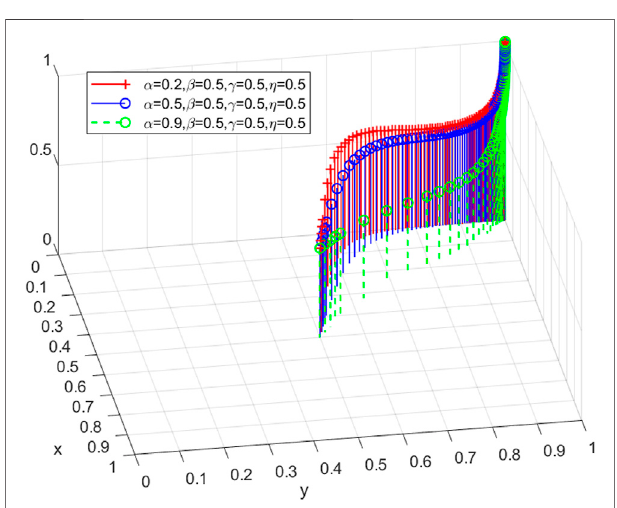
FIGURE 2 | System evolution trajectory under different tax intensities α